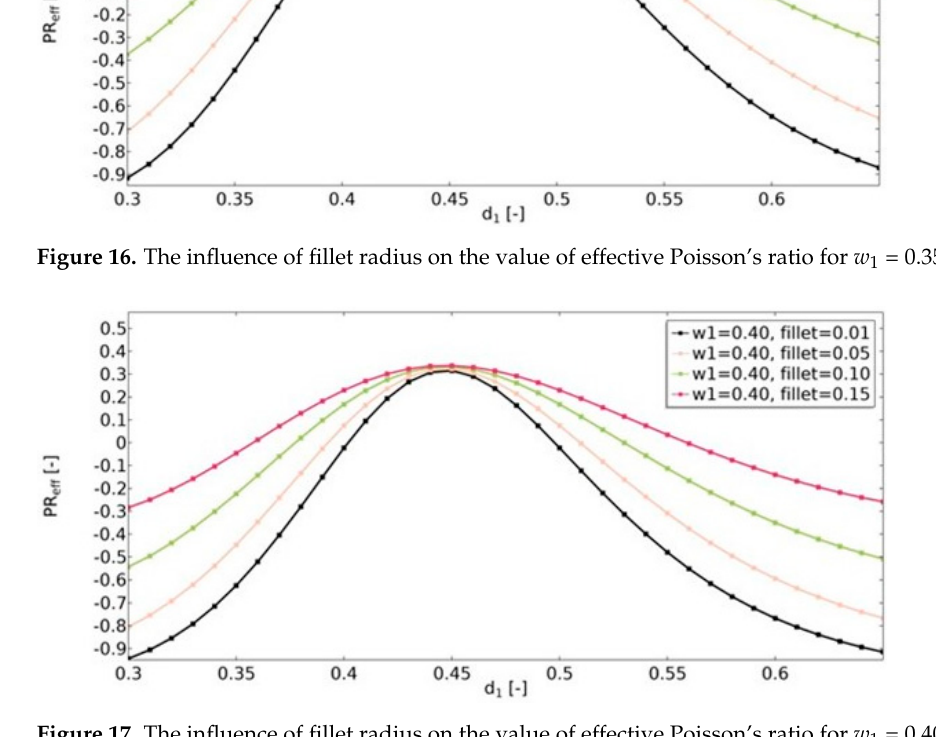
Figure 17. The influence of fillet radius on the value of effective Poisson’s ratio for w 1 = 0.40.